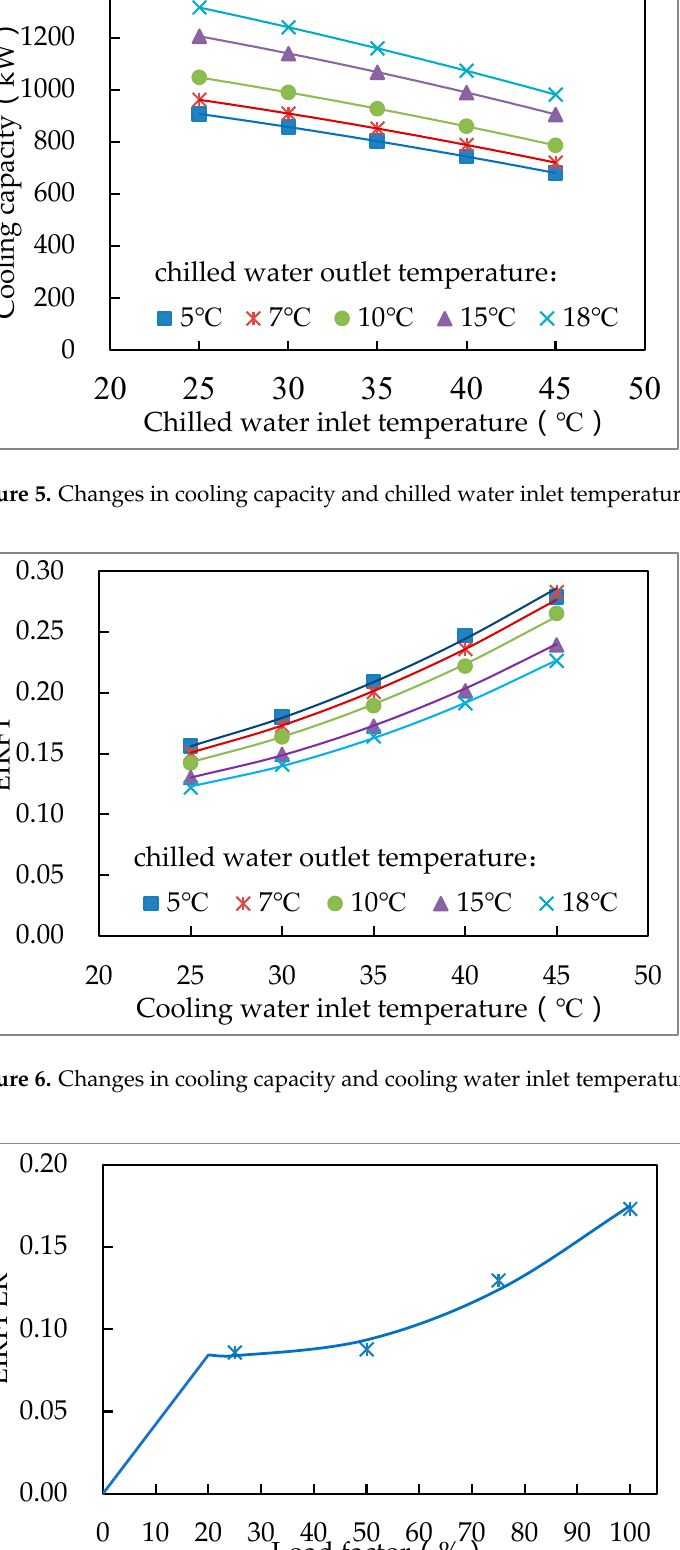
Figure 7. Variation curve of cooling efficiency and part load rate.